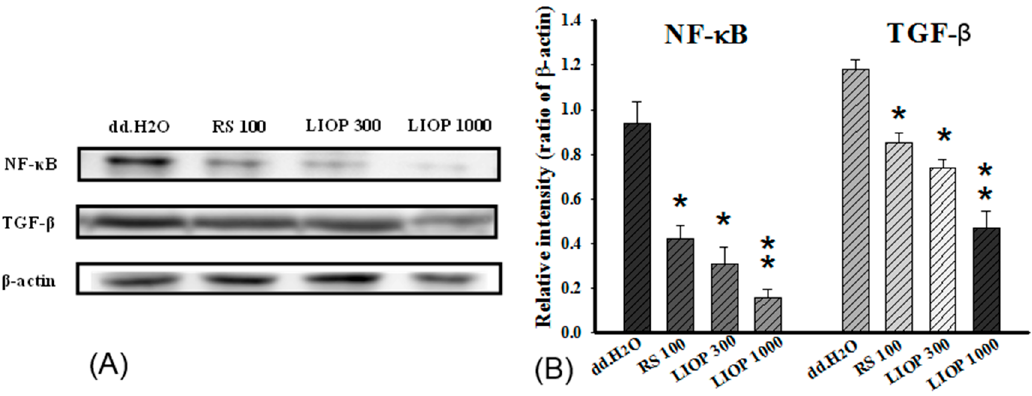
Figure 8. Fibrosis-associated proteins expression in renal tubular epithelial cells. The renal tubular epithelial cells (LLC-PK1) in vitro treated with STZ (8 mM) + AGEs (3 mg/mL) or co-treatment of LIOP (100 and 300 µ g/mL) and RS (100 µ g/mL) were collected after a three-day incubation. Expression levels of the cytoplasmic NF- κ B, TGF- β 1 and β -actin proteins were determined by Western blot and quantitated by microcomputer image device (MCID) image analysis ( A ). The β -actin levels were evaluated as a loading control, and the data are expressed as the NF- κ B(p65)/ β -actin and TGF- β / β -actin ratios, respectively ( B ). Each value represents the mean ± SE of three replicate experiments, and the results are expressed as population growth (control as 100%). *: p < 0.05, **: p < 0.01 significantly different from dd.H 2 O group. dd.H 2 O: vehicle control; RS: rosiglitazone; LIOP: Low-molecular-weight, 10–100 kDa polysaccharides from Inonotus obliquus